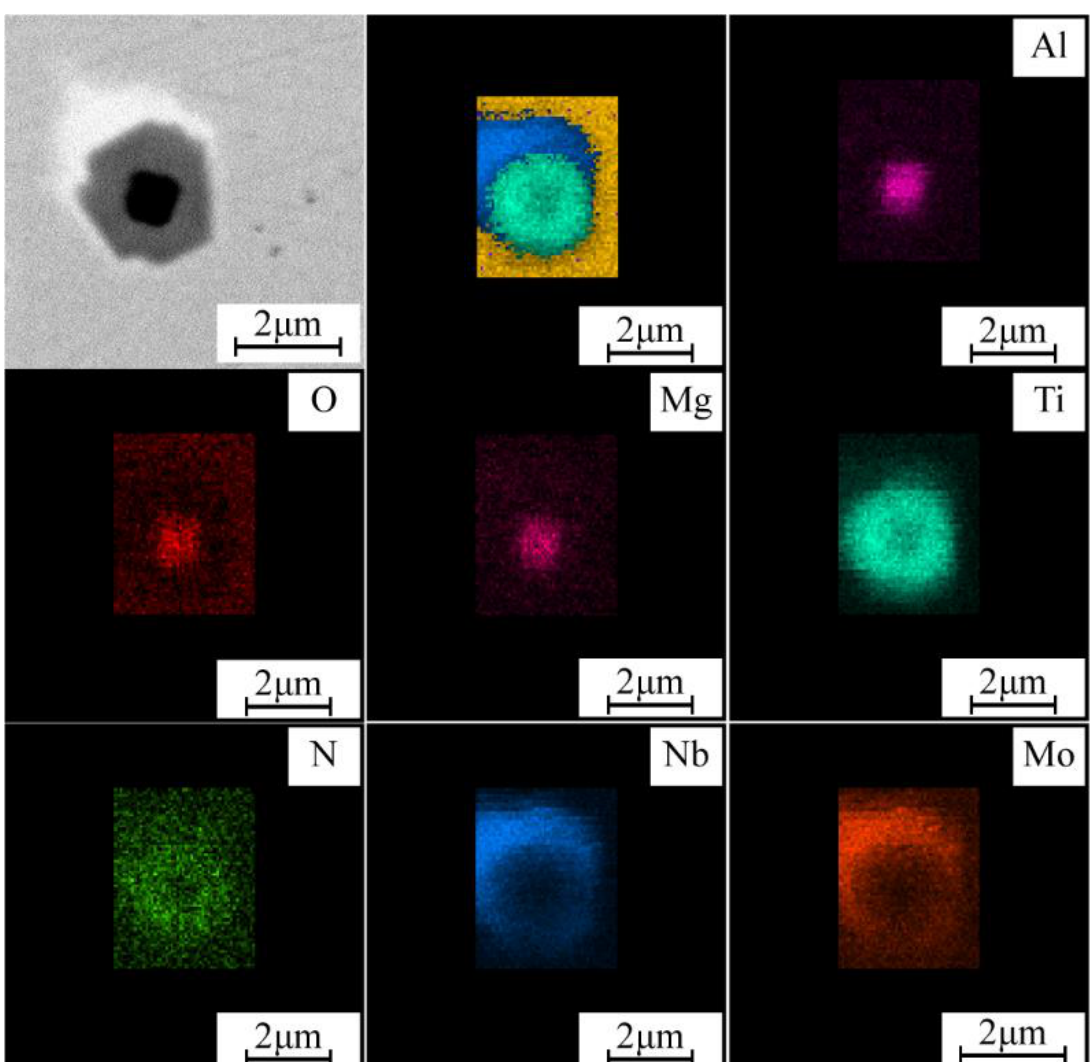
Figure 10. Mapping of a typical multiphase inclusion with a three-layer structure.